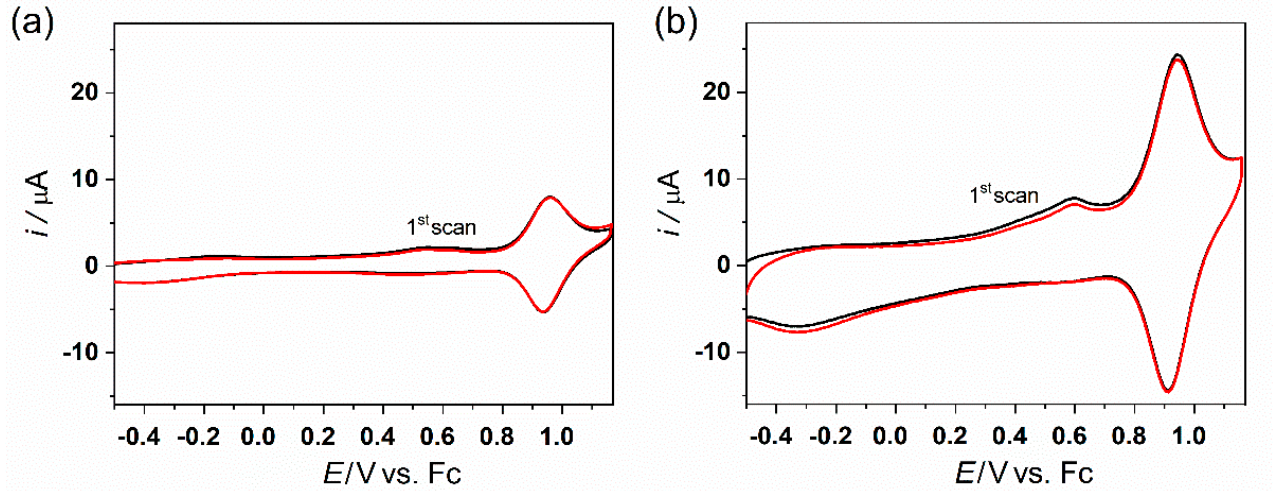
Figure 3. Cyclic voltammogram for Ru-tripod SAM on: ( a ) Au bead polycrystalline electrode in 0.5 M TBAPF 6 in acetonitrile, electrode area 0.267 cm 2 ; ( b ) Au(111) on mica electrode in 0.1 M TBAPF 6 in acetonitrile, immersed geom. area approx. 0.55 cm 2 . Scan rate was 0.1 V s − 1 .